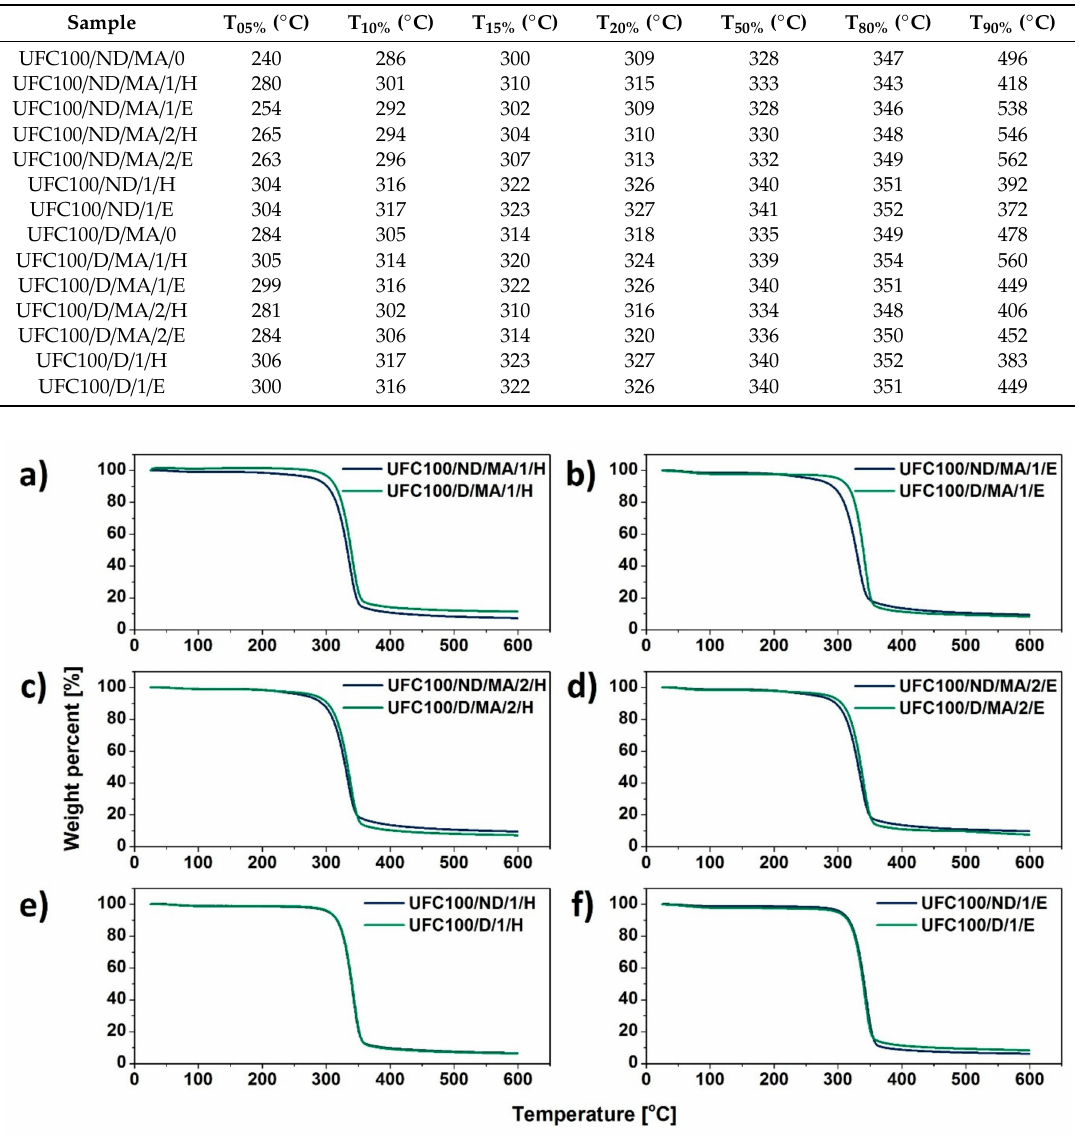
Table 6. Temperatures of the mass loss; T X% —temperature at which the mass loss of x% is detected.